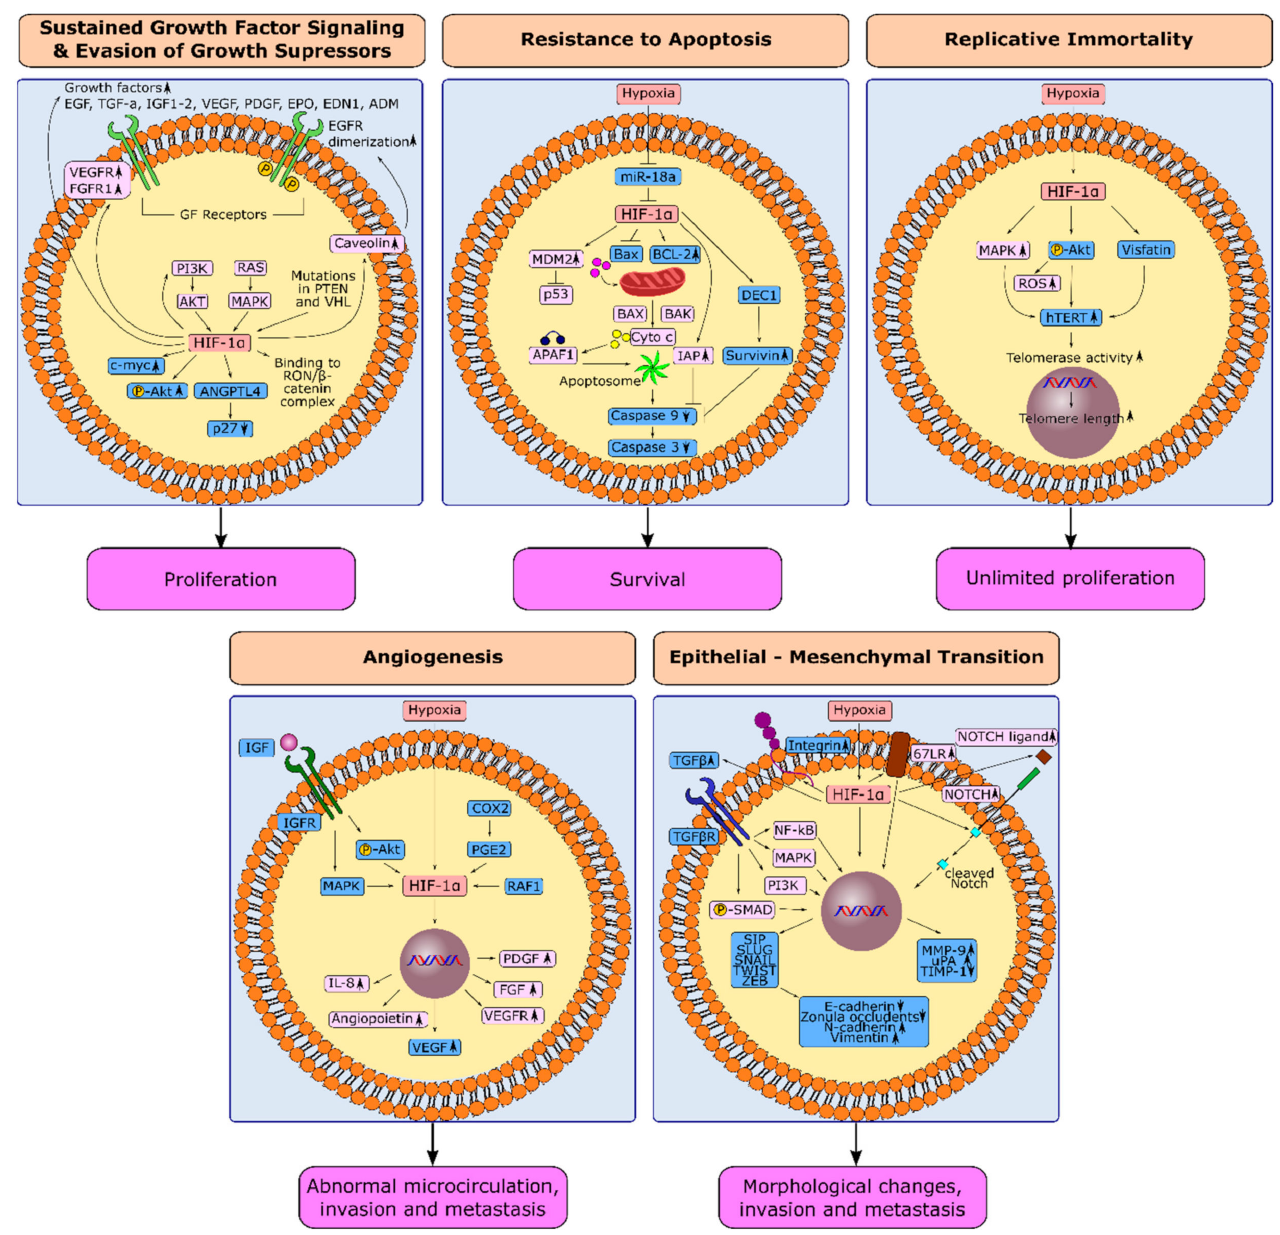
Figure 3. Induction of cancer hallmarks by hypoxia and HIF-1 α in gastric cancer. Hypoxia induces sustained growth factor signaling and evasion from growth suppressors, resistance to apoptosis, replicative immortality, angiogenesis, and epithelial–mesenchymal transition in gastric cancer. Pro- cesses for which there is specific evidence in gastric cancer are shown in blue. Processes common in different cancers are shown in light pink. Upregulation or downregulation of specific proteins is shown with an upward or downward arrow, respectively. The figures were drawn in Inkscape